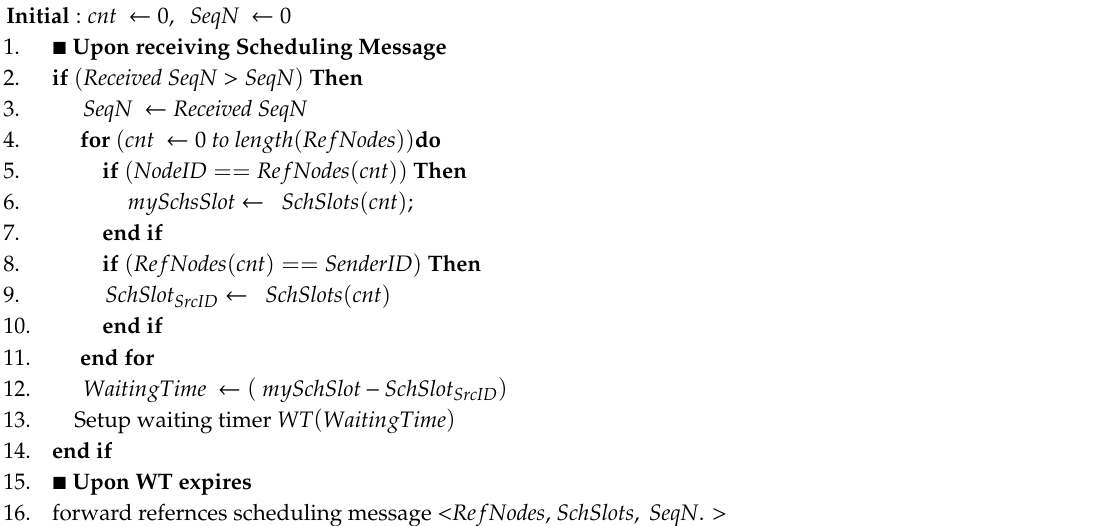
Algorithm 2: EERS pseudo-code for reference scheduling selection (except sink